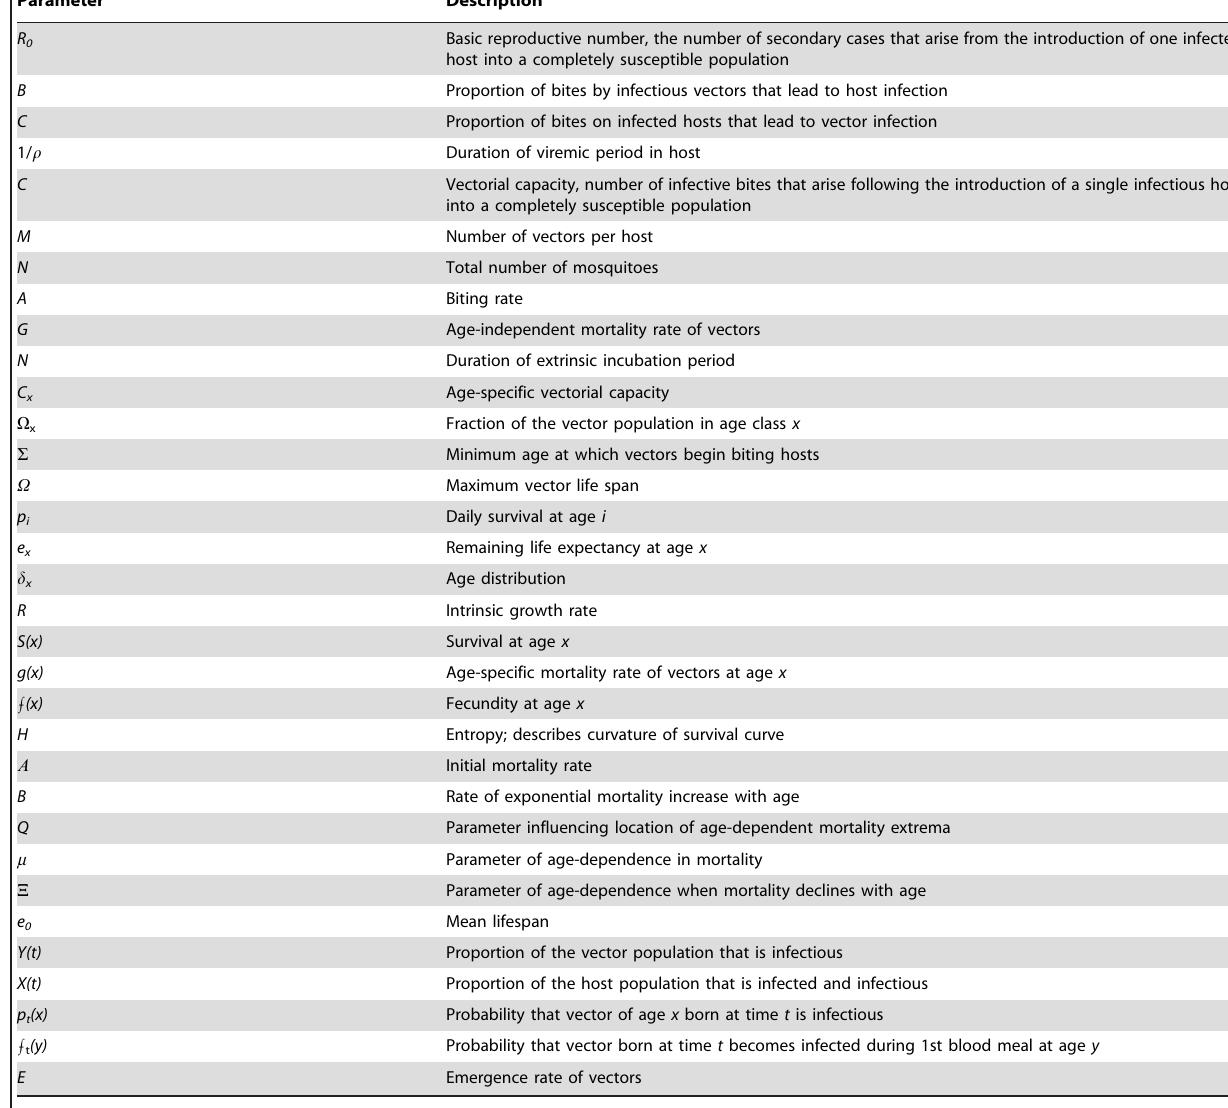
Table 1. Parameter descriptions.